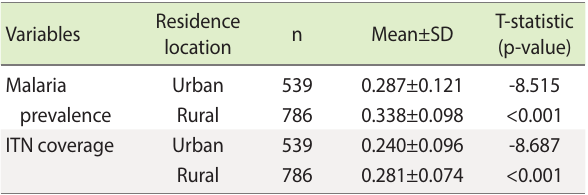
Table 3. Malaria prevalence and ITN coverage between urban and rural areas